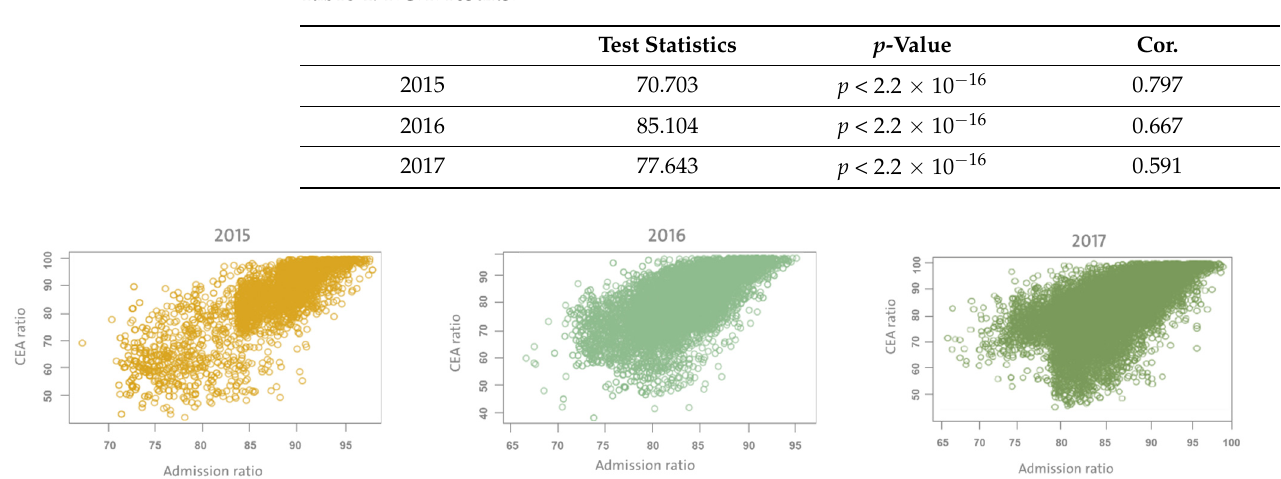
Table 4. P.C.T. results.